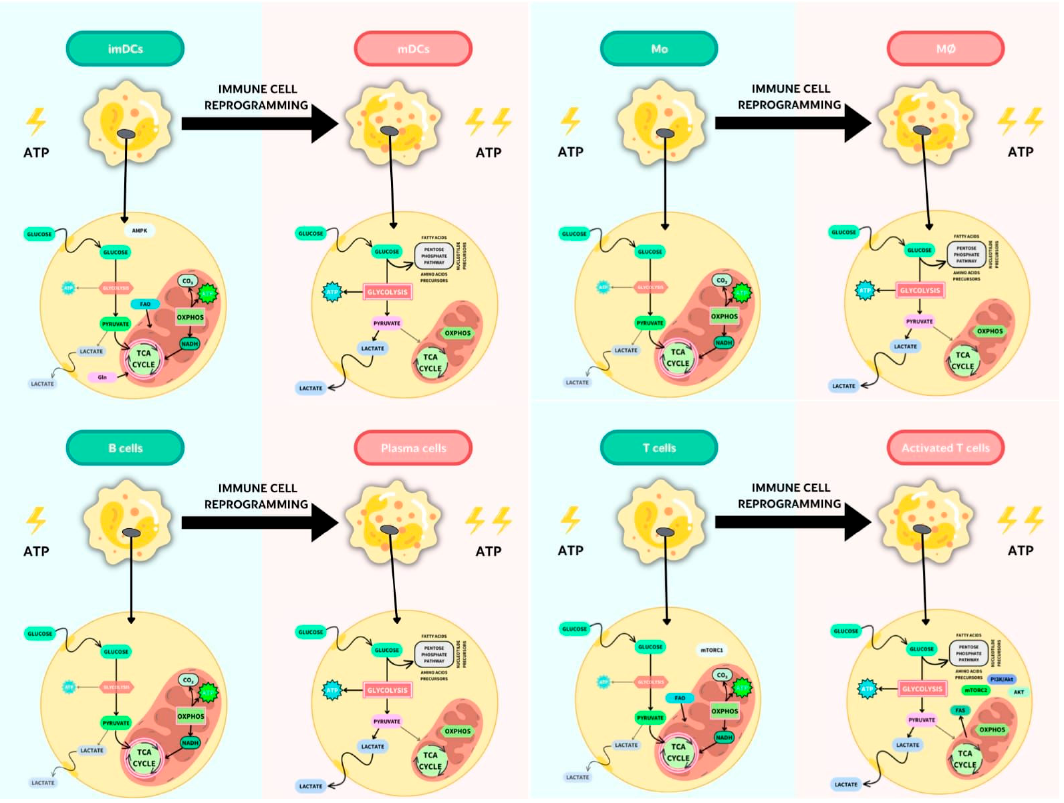
Figure 2. Key metabolic pathways in resting or activated APCs and T lymphocytes.